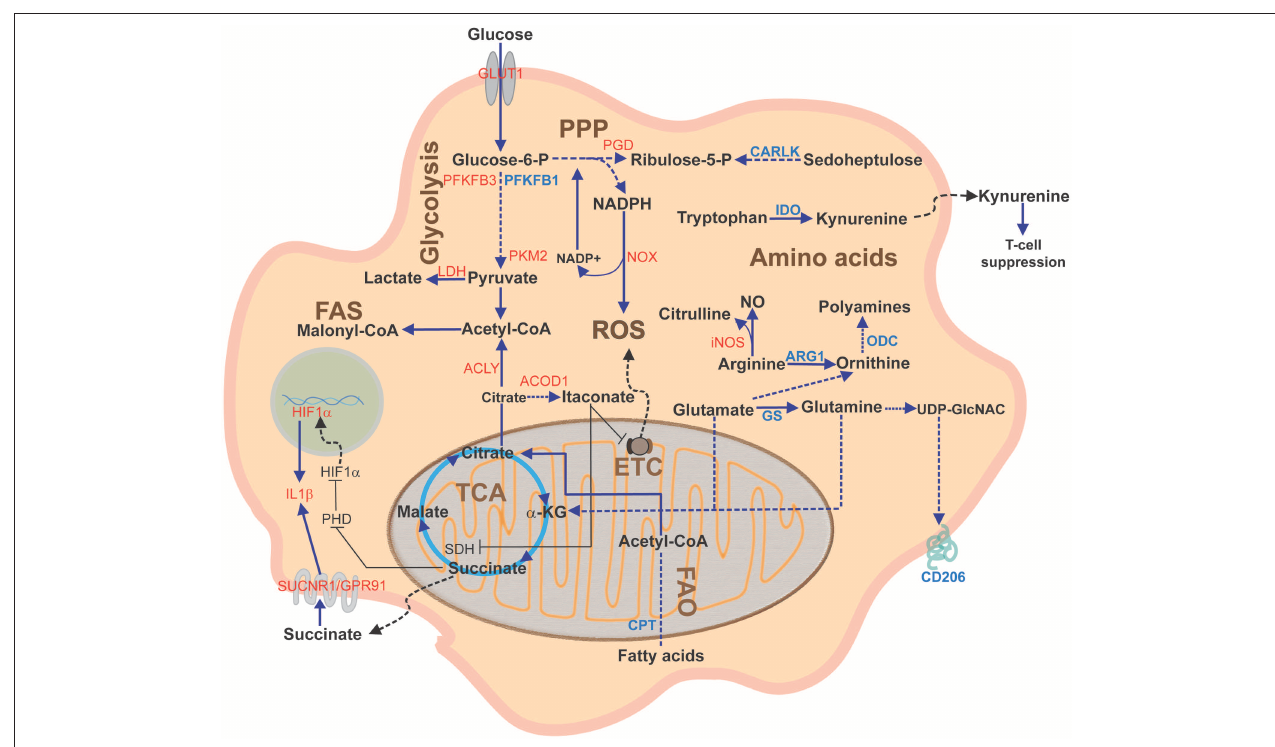
FIGURE 3 | Overview of macrophage metabolic pathways. This diagram depicts the main macrophage pathways during classical and alternative polarization and their components. In red, proteins upregulated in pro-inflammatory (M1) activation; in blue, proteins upregulated during anti-inflammatory (M2) activation. α -KG, alpha-ketoglutarate; ACLY, ATP citrate lyase; ARG1, arginase1; CARLK, car bohydrate k inase- l ike protein; CPT, carnitine palmitoyl transferase; ETC; Electron Transport Chain; FAO Fatty acid oxidation; FAS, Fatty acid synthesis; GS, glutamine synthetase; GLUT1, glucose transporter 1; IDH, Isocitrate dehydrogenase; IDO, indoleamine dioxygenase; iNOS, inducible nitric oxide synthase; LDH, lactate dehydrogenase; NO, nitric oxide; NOX, NADPH oxidase; ODC, ornithine decarboxylase; PGD, phosphogluconate dehydrogenase; PHD, prolyl hydroxylase; PPP, Pentose phosphate pathway; PFKFB3, phosphofructokinase fructose 2,6-biphosphatase B3; PKM2, pyruvate kinase M2; ROS, Reactive Oxygen Species; SDH, Succinate dehydrogenase; SUCNR1, succinate receptor 1; TCA, Tricarboxylic acid cycle or Krebs